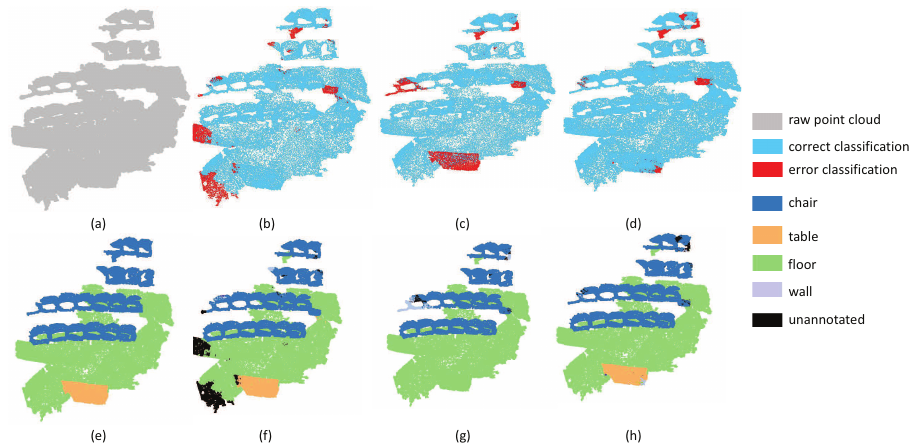
Figure 8. The small object segmentation results on Classroom . ( a ) input, ( e ) ground truth, ( b , f ) the classification result by PointNet++, ( c , g ) the classification result by PointSIFT, and ( d , h ) the classification result by